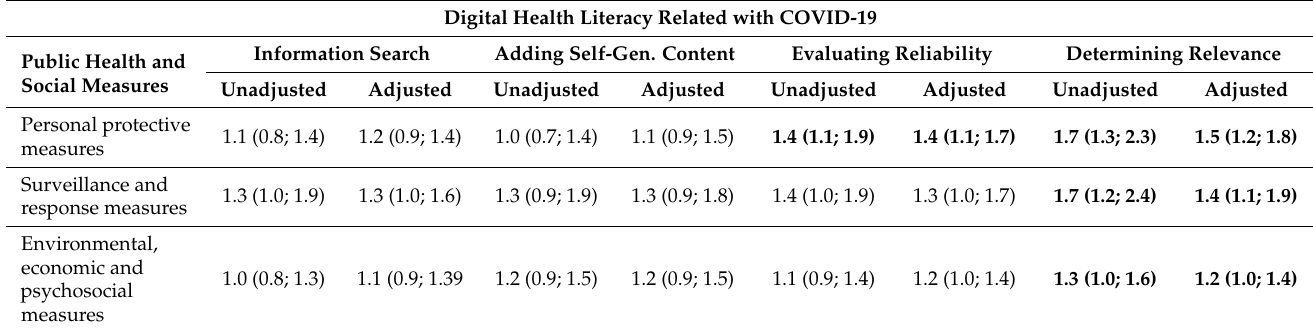
Table 3. Associations between online information about public health and social measures and digital health literacy related to